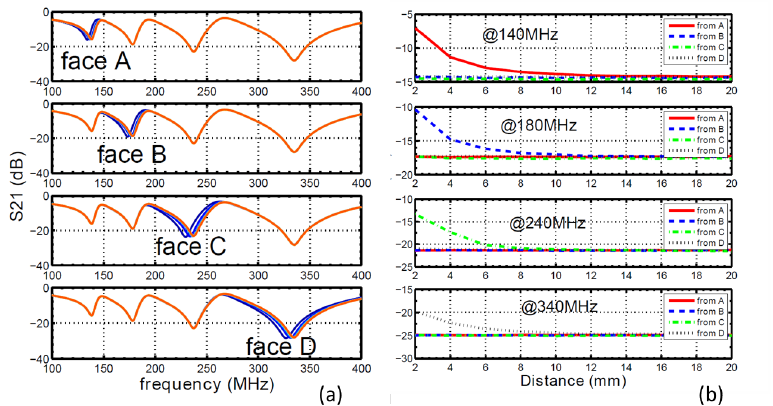
Figure 6. ( a ) Measured transmission spectrum. The four sub-figures indicate the change in capacitance at four sensing elements with different inductance values. In each sub-figure, curves with different colors represent different distances between the target and sensing element; ( b ) The four sub-figures are for the S 21 at different frequencies. The four curves in each sub-figure represent the object coming from four different